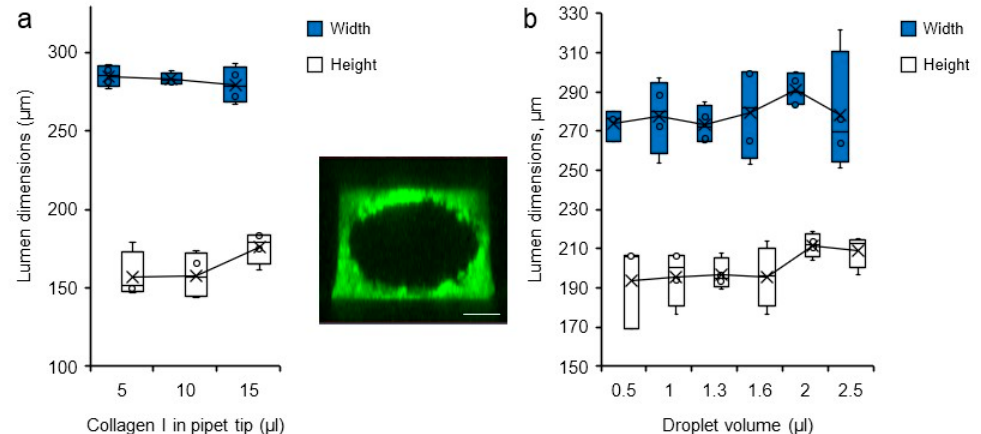
Figure 4. Variations in lumen dimensions. Dimensions (height and width) of the lumens measured by confocal microscopy according to ( a ) the volume of collagen I solution loaded in the pipet tip at the time of channel filling n = 4, and ( b ) the volume of droplets loaded into the microchannel filled with collagen solution, n = 4. ( insert ). Confocal microscopy maximum intensity projection 3D recon- struction of a representative collagen I/BSA-FITC channel used for measurements, bar = 200 µm.